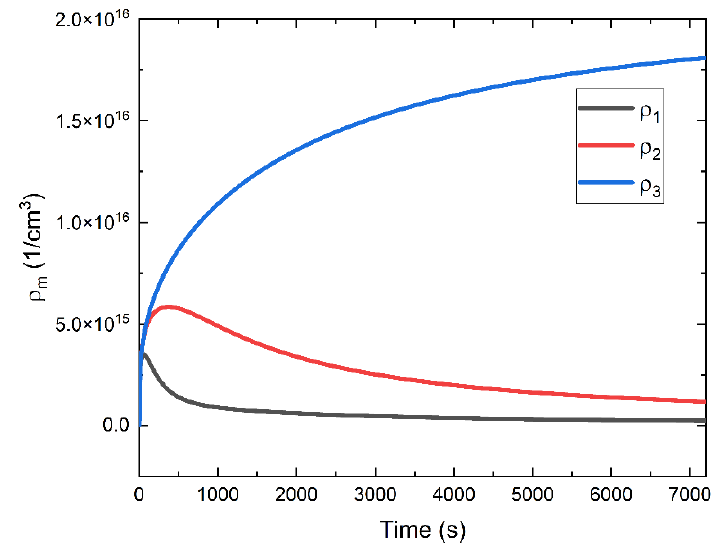
Figure 12. The occupancy of trapping sites, segmented into three discrete levels, plotted as a function of time. Here, these data are obtained from the simulated kinetics corresponding to a nominal field of 20 V/ µ m. Note that these data are simulated from the unmodified model, where hopping-assisted release and capture is not accounted